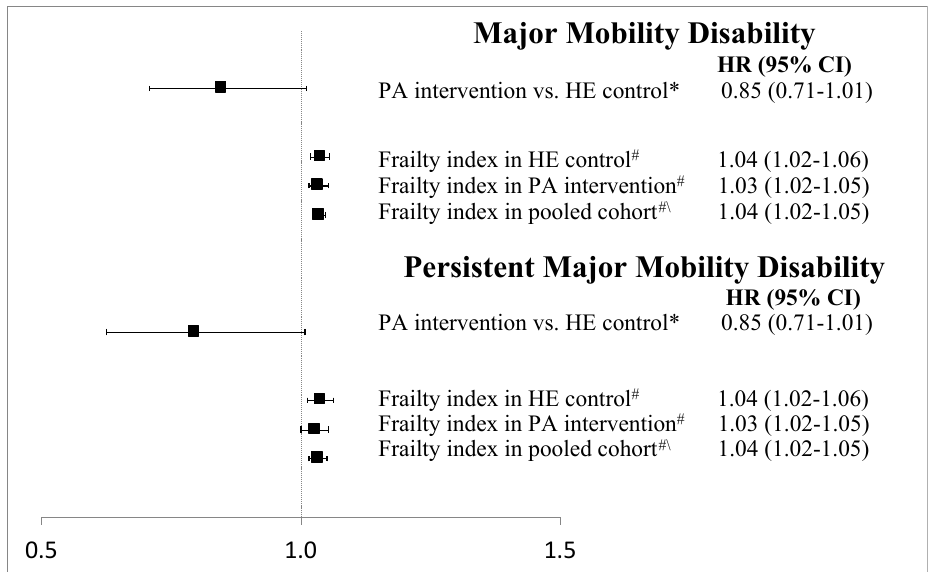
0.5 Figure 3. Cox proportional hazard regression results of the interaction between the LIFE Study intervention and a continuous frailty index for both major mobility disability and persistent major mobility disability. * Results show the overall effect of the physical activity (PA) intervention compared with the health education (HE) control arm at the mean frailty index. # Per 1 ‐ unit change in frailty index. #\ Results for the overall pooled cohort.